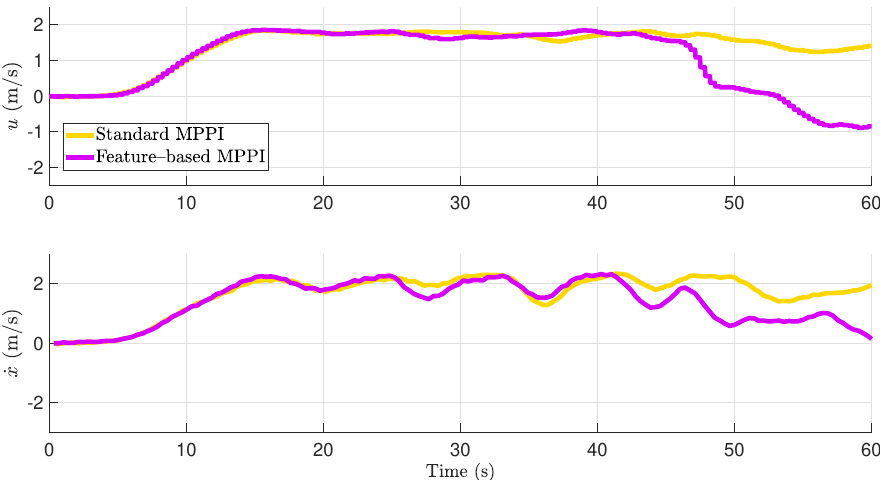
Figure 10. Comparison of the body–fixed surge velocity u and the velocity ˙ x in x direction in local